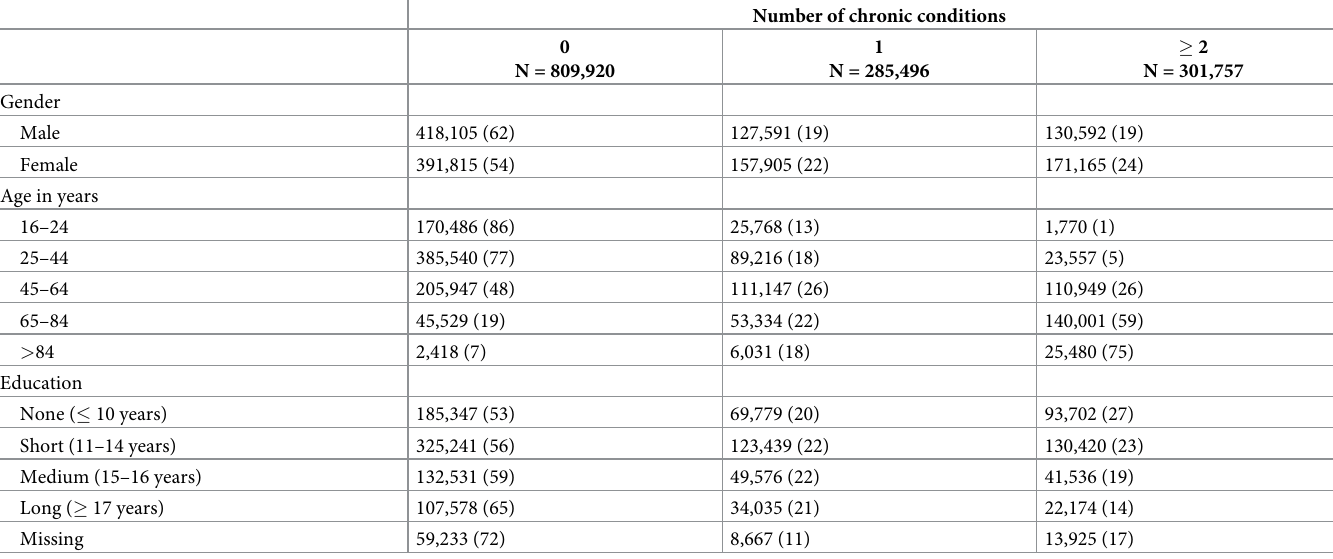
Table 2. Distributions of the study population (N = 1,397,173) by gender, age, and educational attainment and number of chronic conditions, N